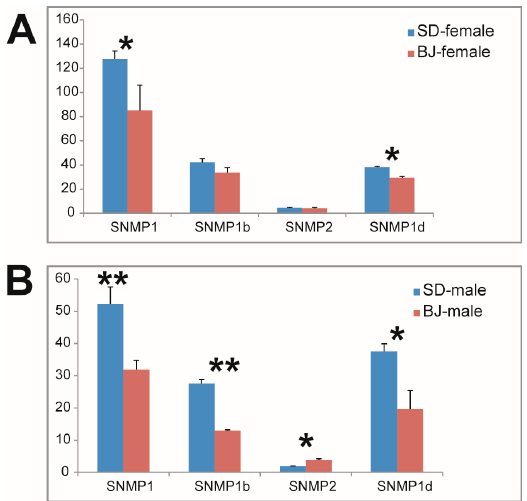
Figure 3. Comparison of sensory neuron membrane protein (SNMP) genes expression levels in both sexes of the two S. bifasciatus populations. The vertical axis refers to the expression level of the genes (FPKM values, mean ± SE, n = 3). ( A ): SNMPs expression level comparison between females of the two population; ( B ): SNMOs expression level comparison between males of the two population. BJ, Beijing population; SD, Shandong population. * means the difference is significant at the 0.05 level; ** means the difference is significant at the 0.01 level.